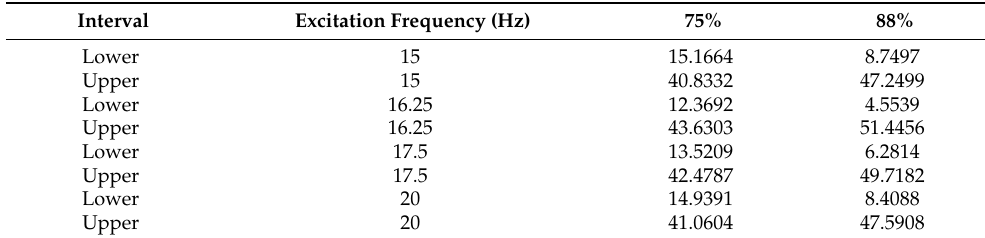
Table 5. Intervals obtained by Chebyshev’s theorem.